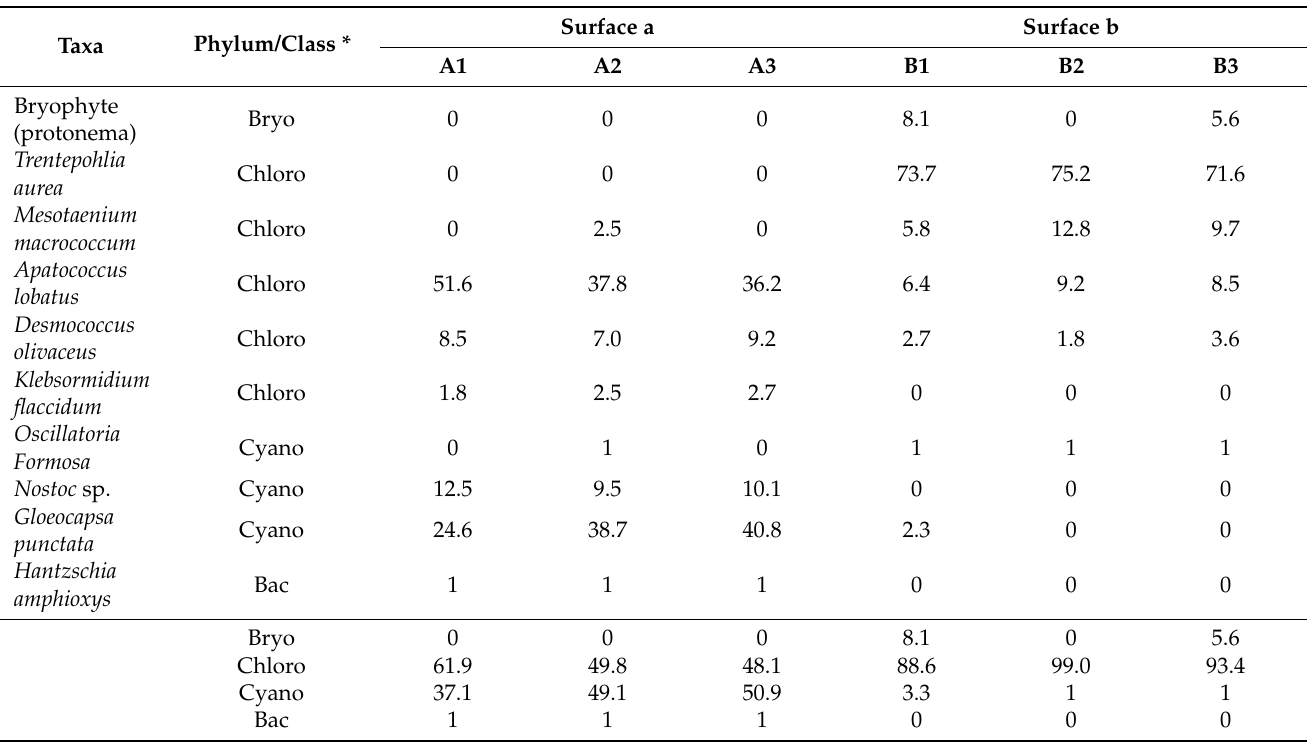
Table 1. Composition and relative abundance of the subaerial biofilm taxa studied in the samples collected from Surface a (A1, A2, A3) and from Surface b (B1, B2,